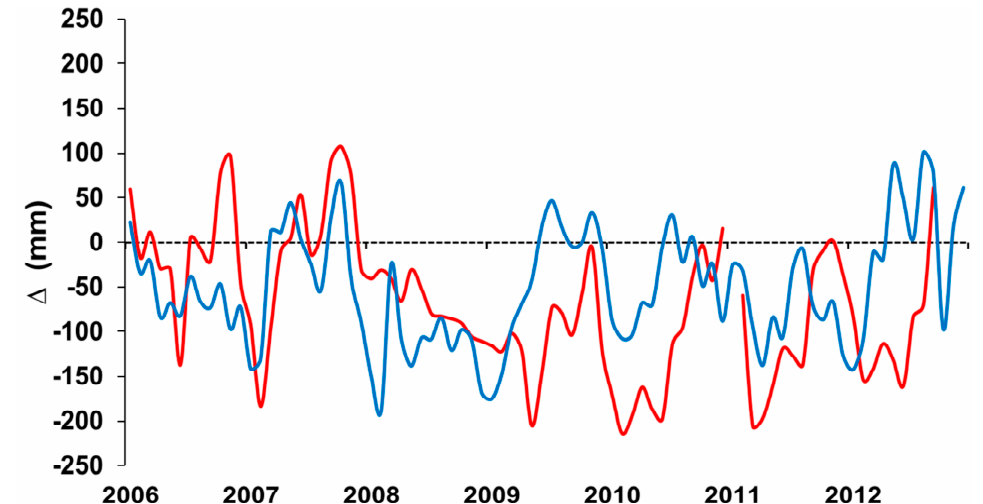
Figure 10. Monthly changes in the estimated water storage for the Santa Catalina stream basin as calculated from the GRACE images (red) and as modelled with SWAT (blue).